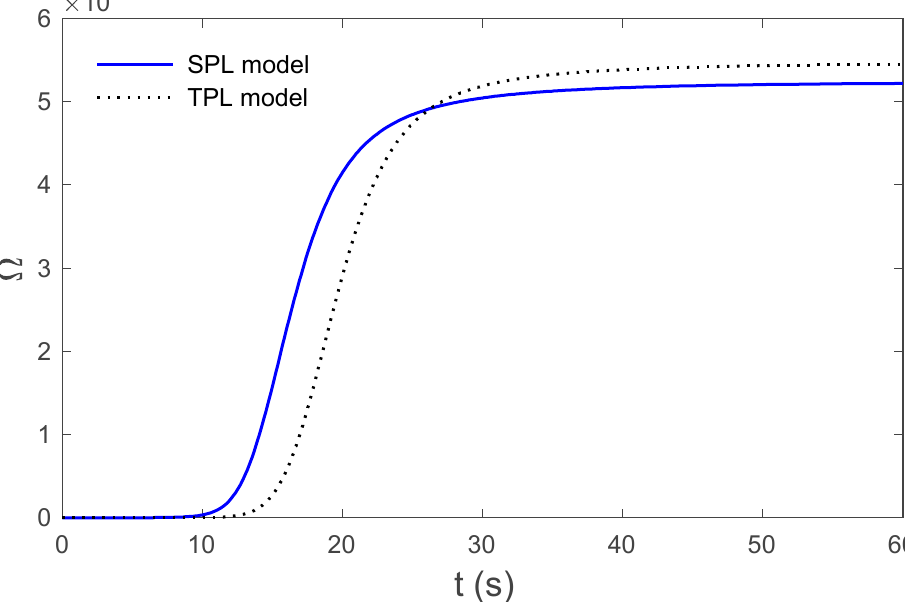
Figure 4. Variations in thermal damage for the SPL and TPL models at the skin surface 𝑥 = 0 .